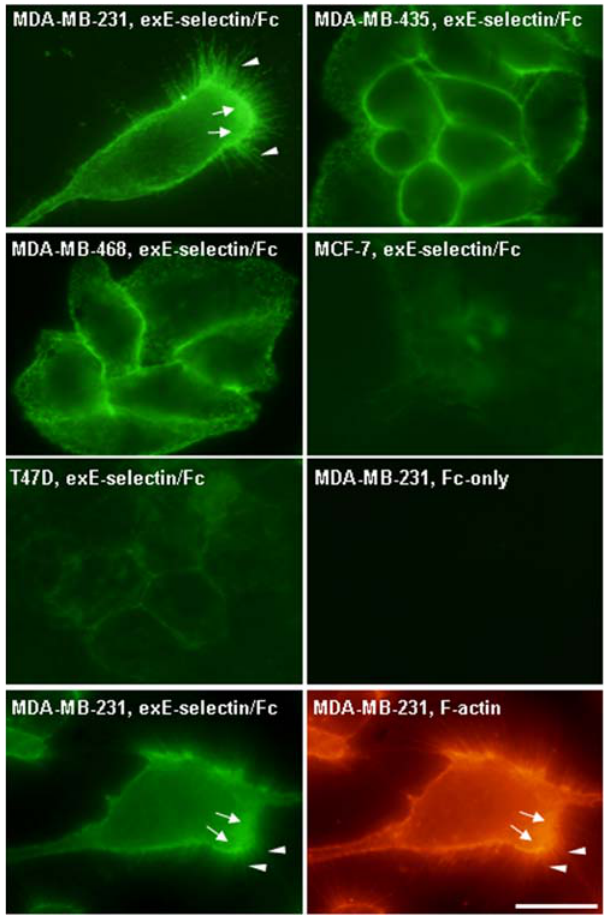
Figure 3. Localization of potential E-selectin ligand(s) on the breast cancer cell surface. A: After blocking with 5% normal goat serum in PBS, breast cancer cells cultured in a tissue culture dish were incubated with exE-selectin/Fc (10 m g/ml) in blocking solution for 1 h at 4 u C. Following three washes, cells were fixed with 3.5% paraformalde- hyde (5 min, 20 u C) and the bound exE-selectin/Fc was detected by Alexa Fluor 488-conjugated anti-rabbit Fc. Cell surface labeling with Fc- only served as a background control. B: To determine the localization of E-selectin ligand on metastatic tumor cell surfaces during migration, MDA-MB-231 cells were double labeled with soluble exE-selectin/Fc for E-selectin ligand (left panel) and rhodamine-conjugated phalloidin for F-actin (right panel). Bar, 20 m m.